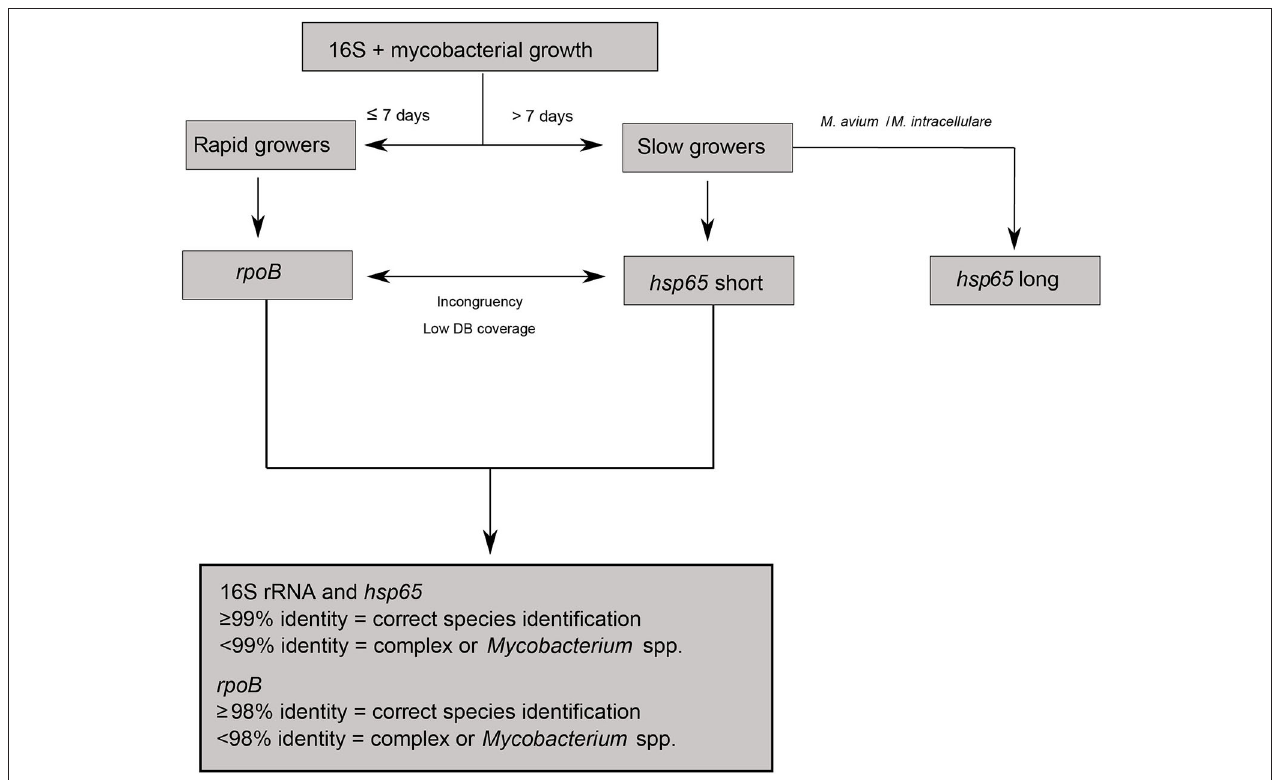
FIGURE 1 | Algorithm describing species identification through Sanger